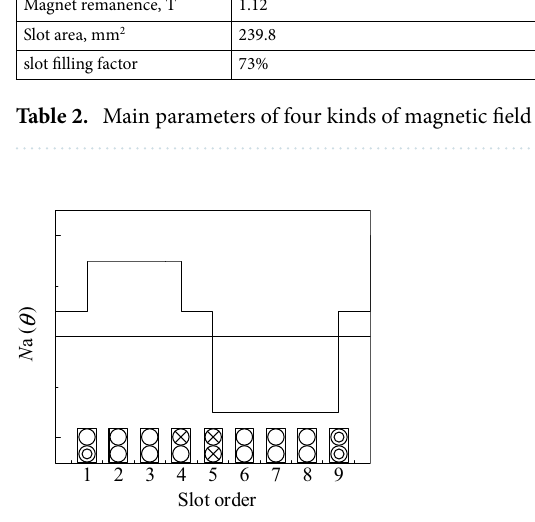
Figure 3. A-phase winding function.